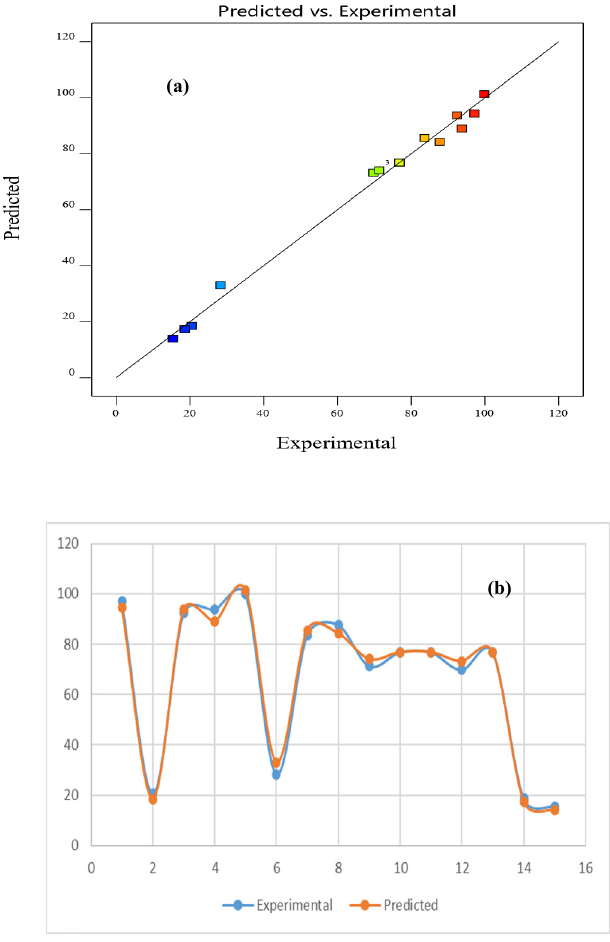
Fig. 7. (a) Linear and (b) Non-Linear correlation between experimental and predicted Degradation % on